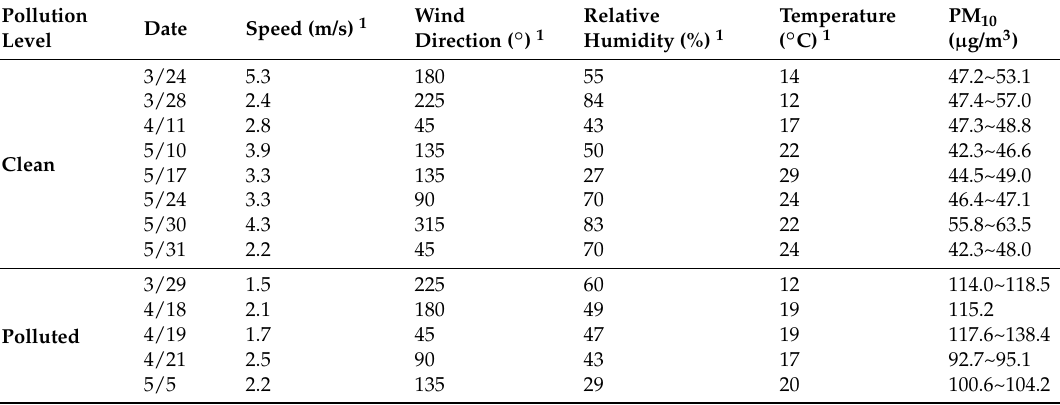
Table 1. Descriptions of meteorological conditions and background concentrations of PM 10 ( μ g/m 3 ).